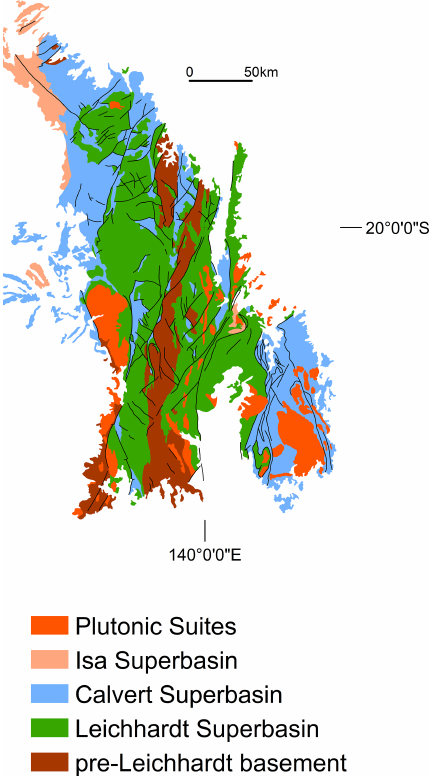
Figure 2. Map showing presently defined limits of outcropping Le- ichhardt, Calvert, and Isa superbasins across the Mount Isa region. Seismic reflection data indicate that all three basins are variably pre- served in the subsurface geology beneath the South Nicholson and Georgina basins and continue northwards into the McArthur Basin and Batten Trough (see Carr et al., 2019). Reproduced with permis- sion: Licensed CC BY version 4.0. © State of Queensland, 2020.